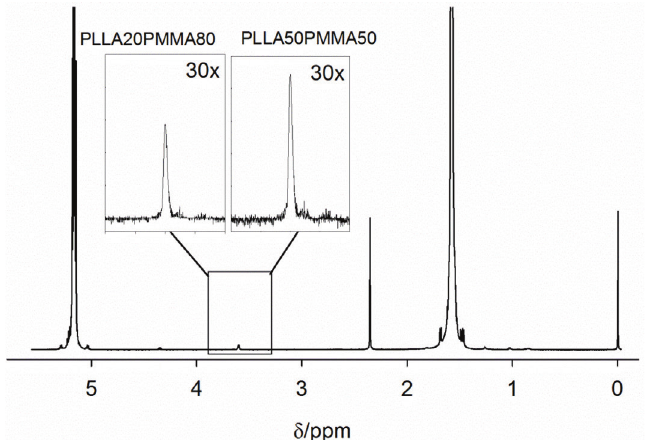
Fig. 2 – Number (M ), weight (M n ages (M